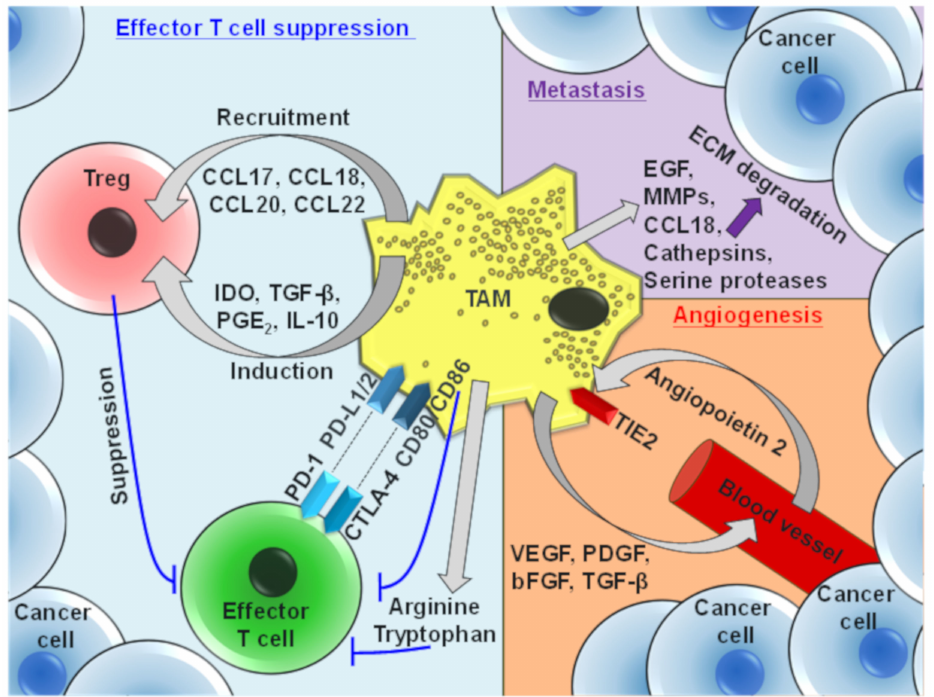
Figure 2. Major protumor functions of tumor-associated macrophages. TAMs mediate suppression of effector T cells via the secretion of soluble proteins and through the expression of inhibitory cell surface molecules. TAMs also produce several factors that promote extracellular matrix (ECM) degradation, which facilitates tumor metastasis. Furthermore, TAMs secrete cytokines that promote angiogenesis, consequently accelerating tumor